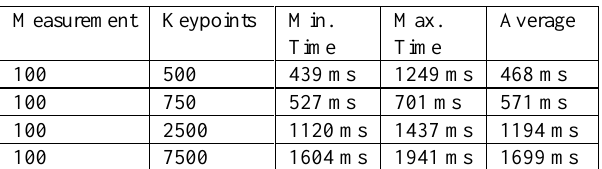
Table 1. Excerpt of the test results of the time measurement by increasing keypoints, (Dastageeri et. al.,